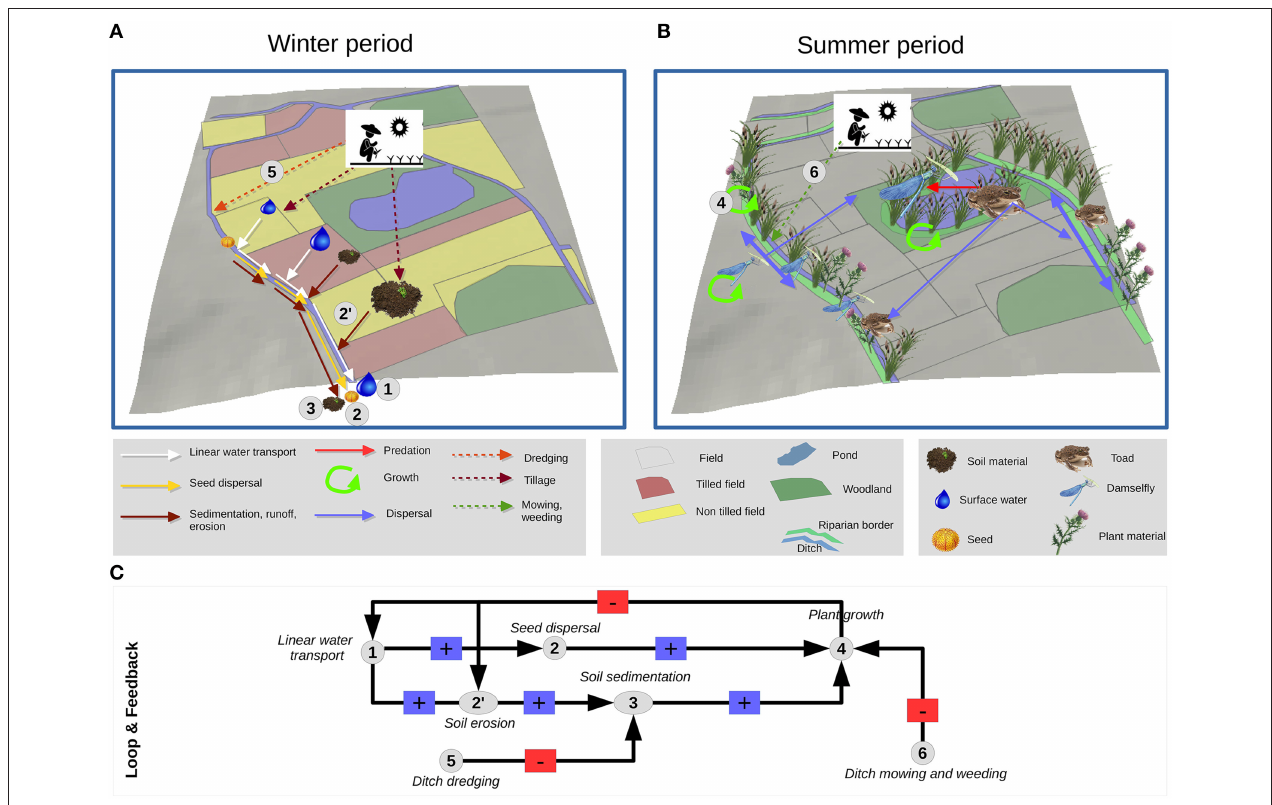
FIGURE 2 | Spatial organization of ILE and MLE during winter (A) and summer (B), with processes indicated by arrows, and positive and negative interactions between processes and between human activities and processes (C). The spatial variability at a given time is represented through variations in state variables attached to MLE (represented by the size of pictogram in A,B) , and variations in landscape properties attached to ILE (differences in colors and